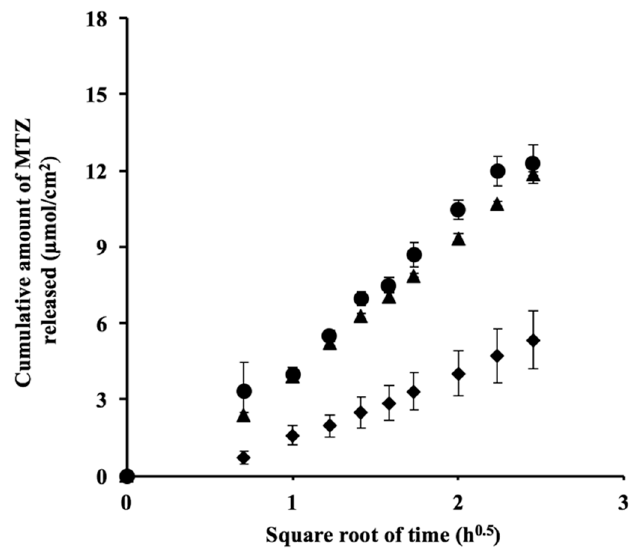
Figure A1. Higuchi plot analysis of the in vitro release of MTZ from different concentrations of Pal-GH gels. Symbols: : F2.5 MTZ , : F5 MTZ , : F10 MTZ (Mean ± S.E., n = 4).